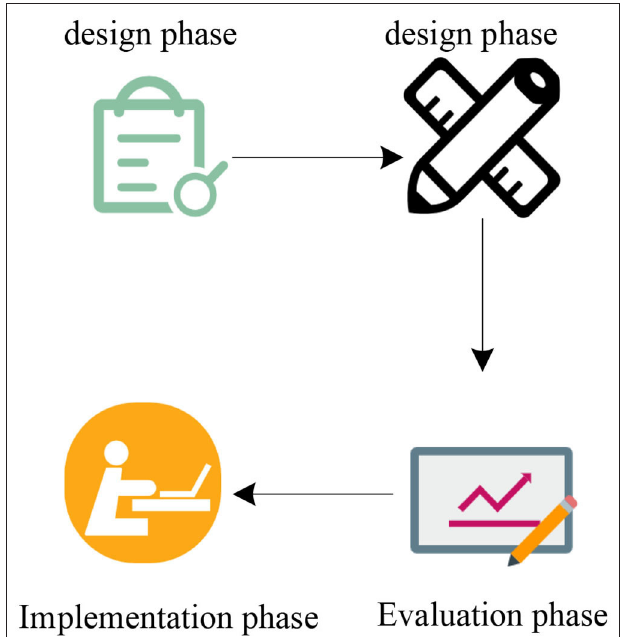
FIGURE 5 | General model of instructional system design.